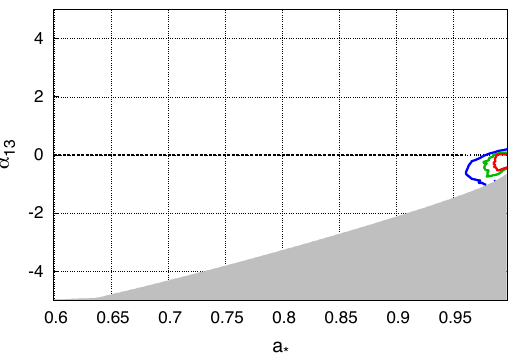
Figure 4. Constraints on the spin parameter a ∗ and the Johannsen parameter α 13 from the study in Ref. [60] of Suzaku data of Ark 564. The red, green, and blue lines indicate, respectively, the 68%, 90%, and 99% confidence level curves for two relevant parameters. The grayed region is ignored because those spacetimes violate the constraint in Equation